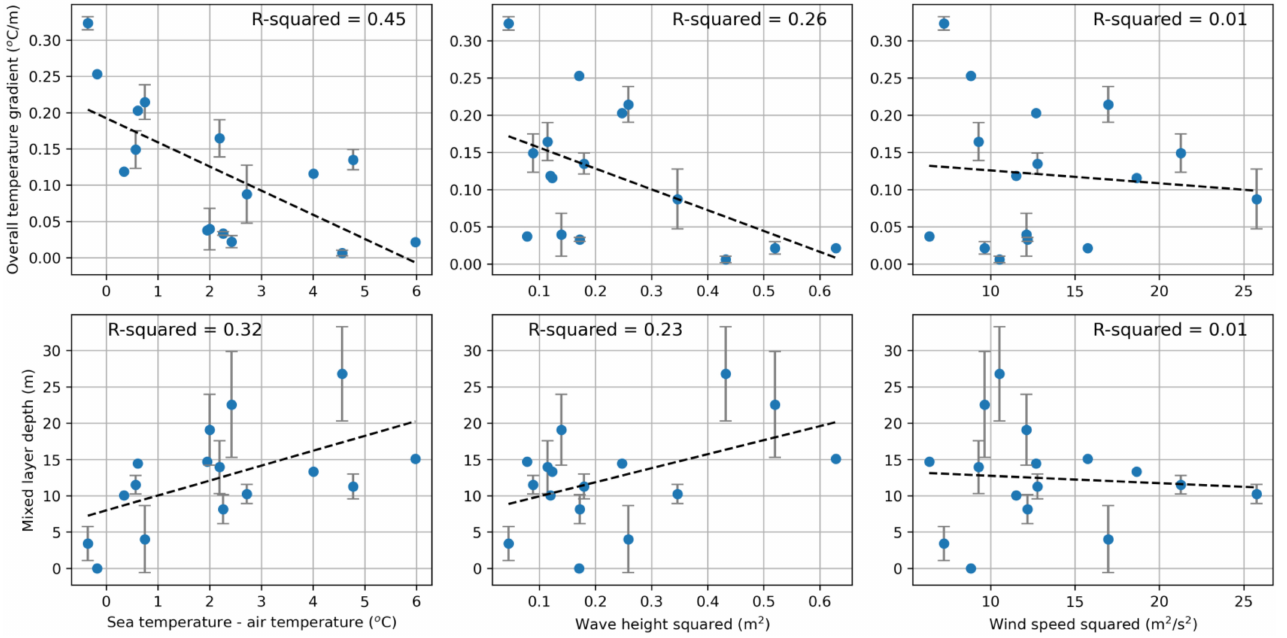
Figure 12. Scattered plots of (top panels) overall temperature gradient and (bottom panels) mixed- layer depth as a function of (from left to right) sea–air temperature difference, squared significant wave-height and squared wind-speed. The correlation coefficients are